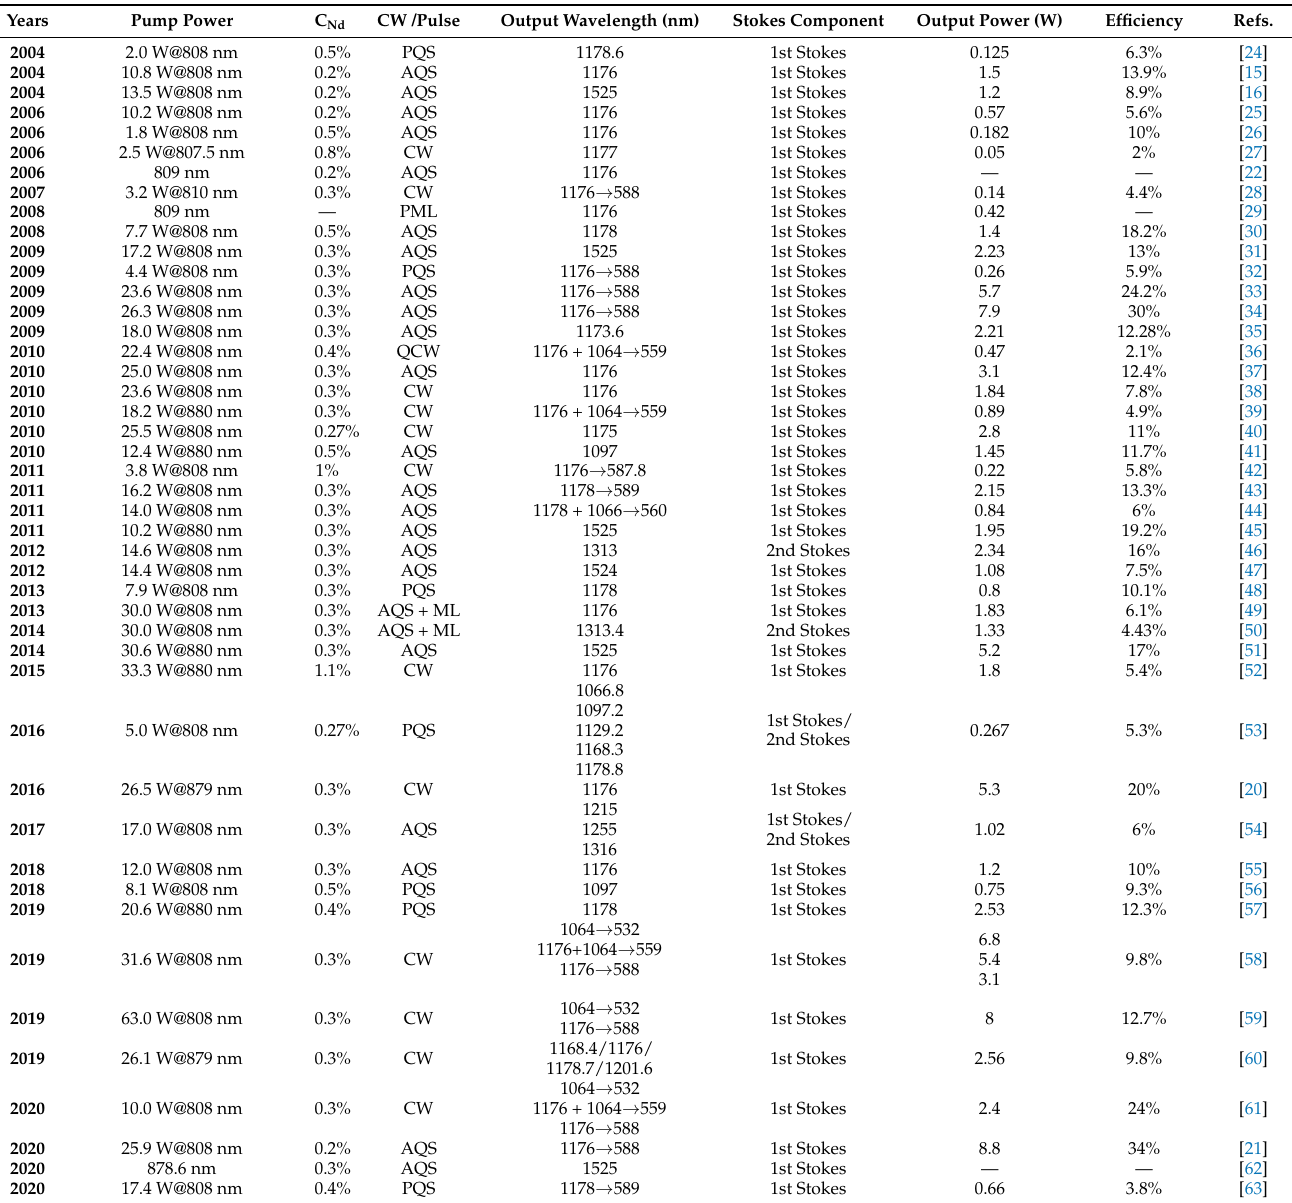
Table 2. Research progress on Nd:YVO 4 self-Raman